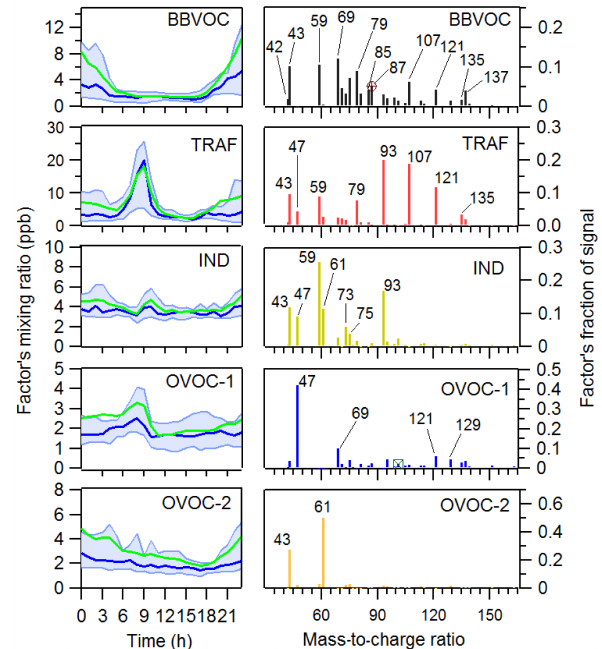
Figure 10. Results of Athens winter campaign PMF analysis. The left side shows the diurnal profiles of the factors. Green lines present the average values. The median value is shown with blue. The blue area is the interquartile range. The right side presents the m/z com- position of each factor as a fraction of signal for each m/z .